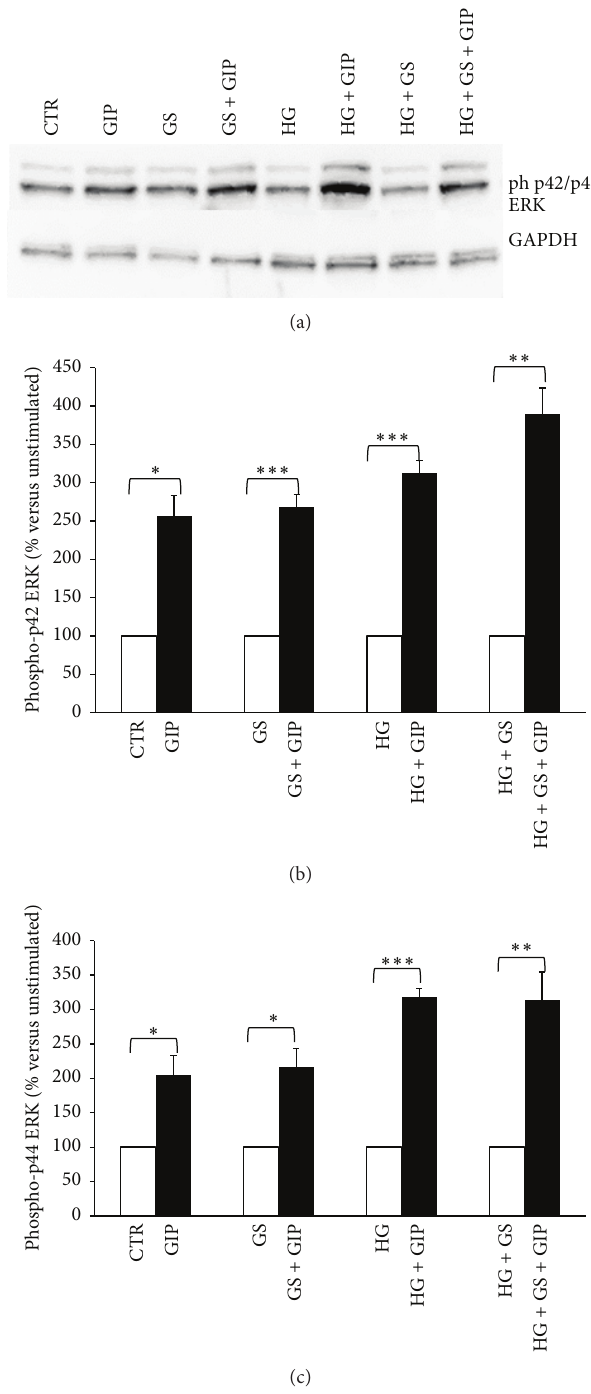
Figure 2: Treatments with GS and HG do not alter GIP-induced phosphorylation of p42/44 ERK (Thr202/Tyr204). After 5-day treatment in the presence of standard medium (CTR) or high glucose concentration (11.1mmol/L) (HG) in presence of glycated serum (GS), HIT-T15 cells were incubated for 2 hours in serum-free medium and then stimulated with 100nmol/L GIP for 5 min (dark bars). (a) Representative western blot analysis. (b), (c) Quantifica- tion of densitometries of western blot bands. Data were expressed as mean ± SE of fold induction relative to GAPDH ( 𝑛 = 3 ). ∗ 𝑃 < 0.05 , ∗∗ 𝑃 < 0.01 , and ∗∗∗ 𝑃 < 0.001 versus absence of